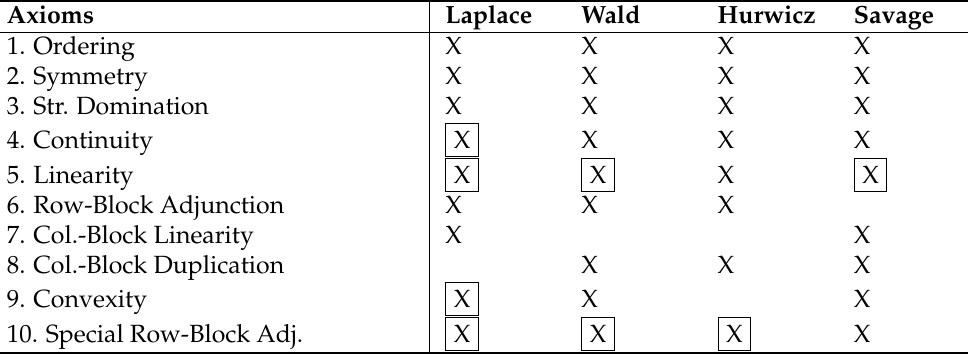
Table 2. The characteristic axioms of 3-dimensional decision